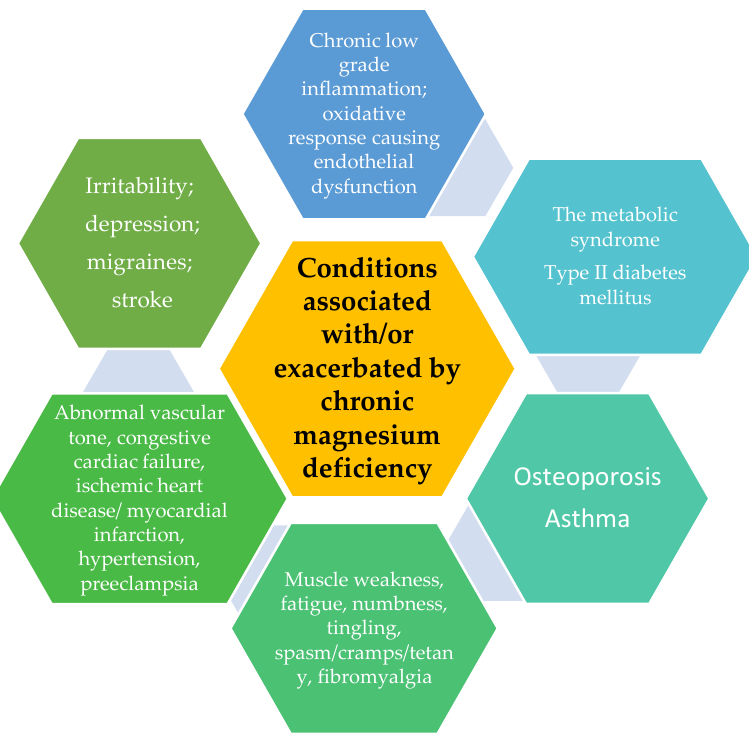
Figure 3. Pathologies connected to/or increasded by chronic magnesium deficiency.